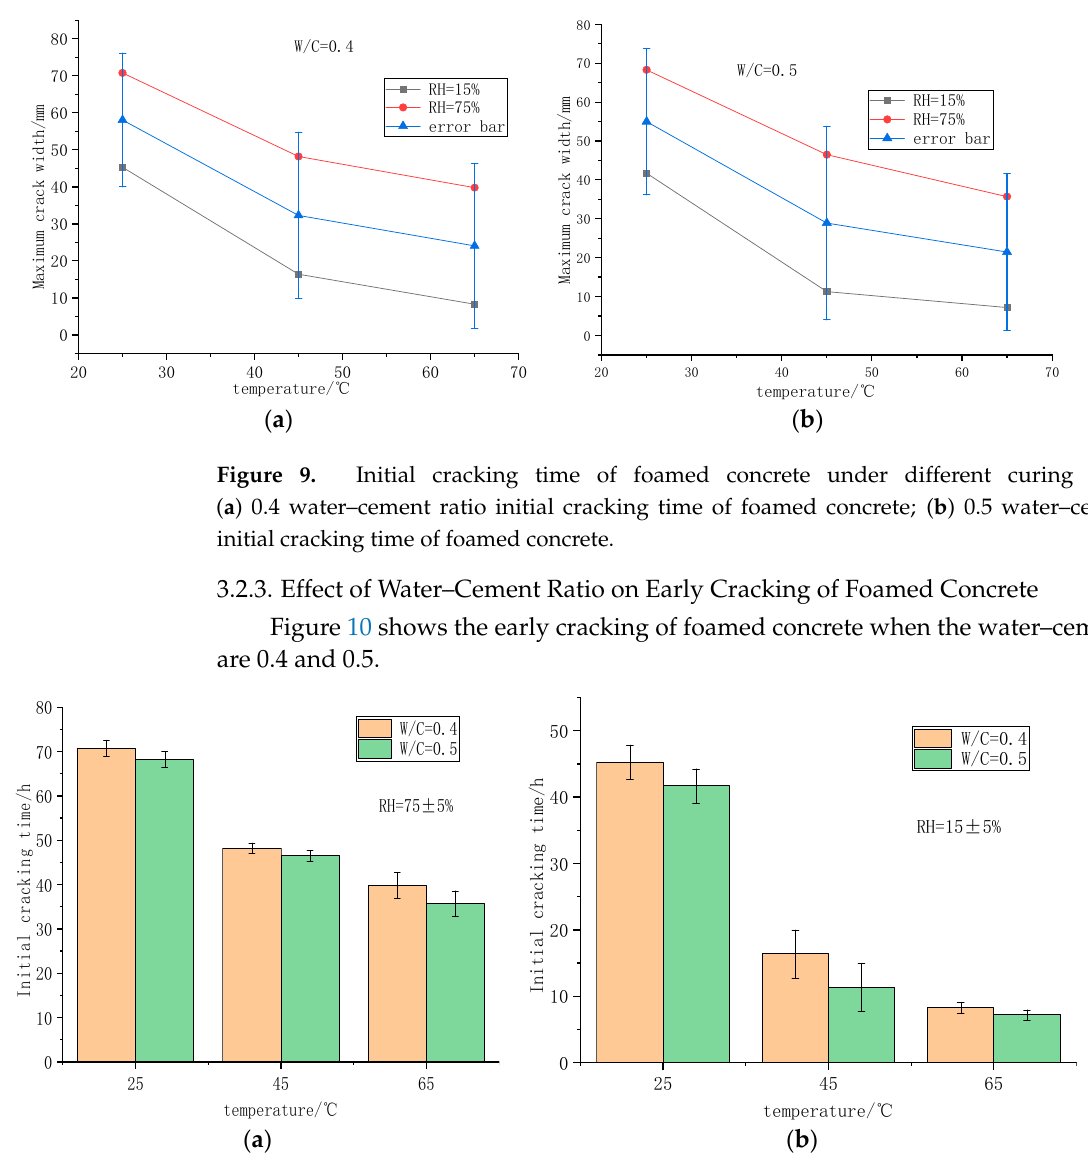
Figure 10. Initial cracking time of foamed concrete with different water–cement ratios: ( a ) RH = 75% initial cracking time of foamed concrete; ( b ) RH = 15% initial cracking time of foamed concrete.